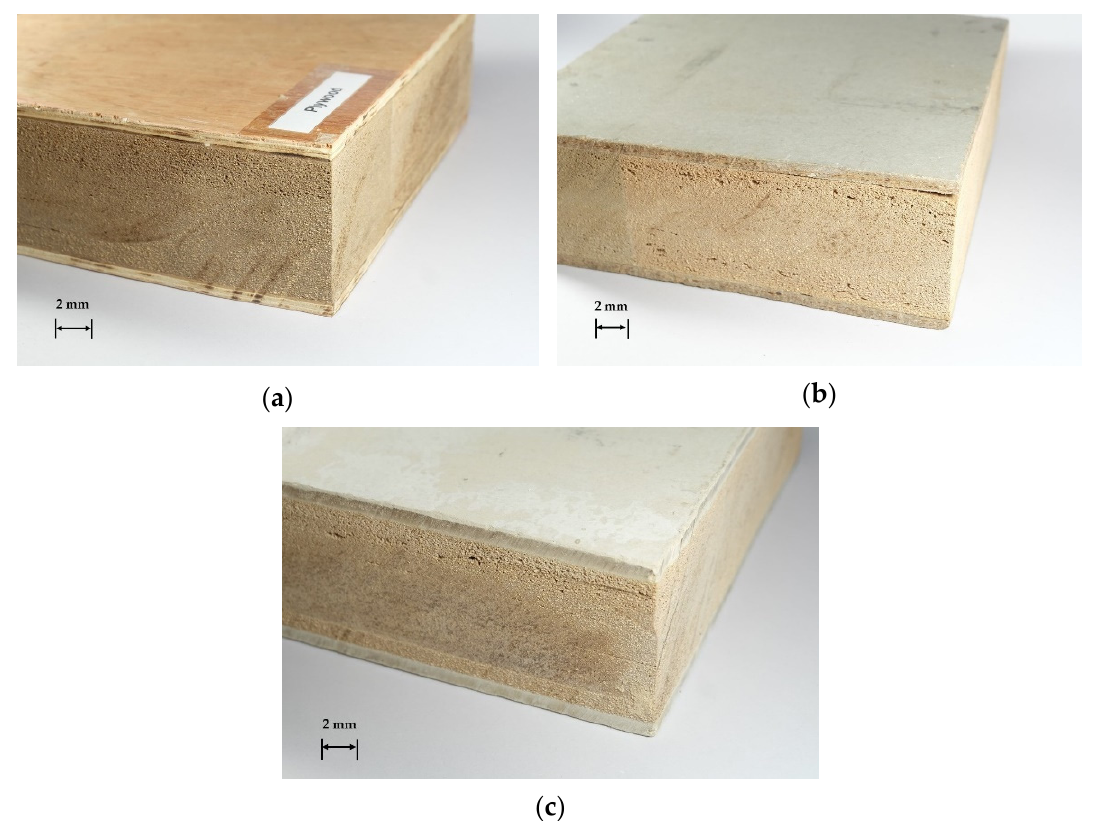
Figure 3. Examples of SIP prototypes made from natural rubber foam covered with ( a ) plywood, ( b ) cement particleboard, and ( c ) fiber-cement board.